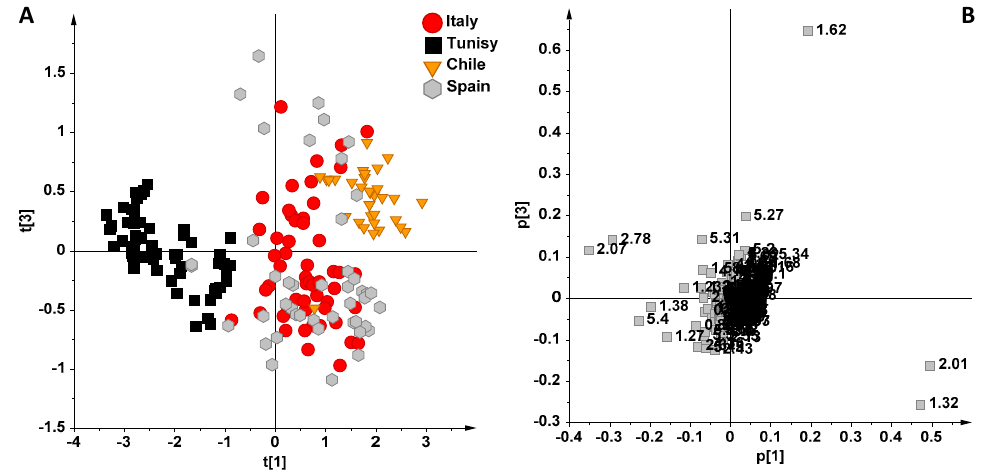
Figure 2. ( A ) PCA (t[1]/t[3] scoreplot for the whole NMR dataset of EVOOs (six components give R2X(cum) = 0.939 and Q2(cum) = 0.859). ( B ) Loading plot for the model; the variables indicated ppm in the 1 H NMR spectra.